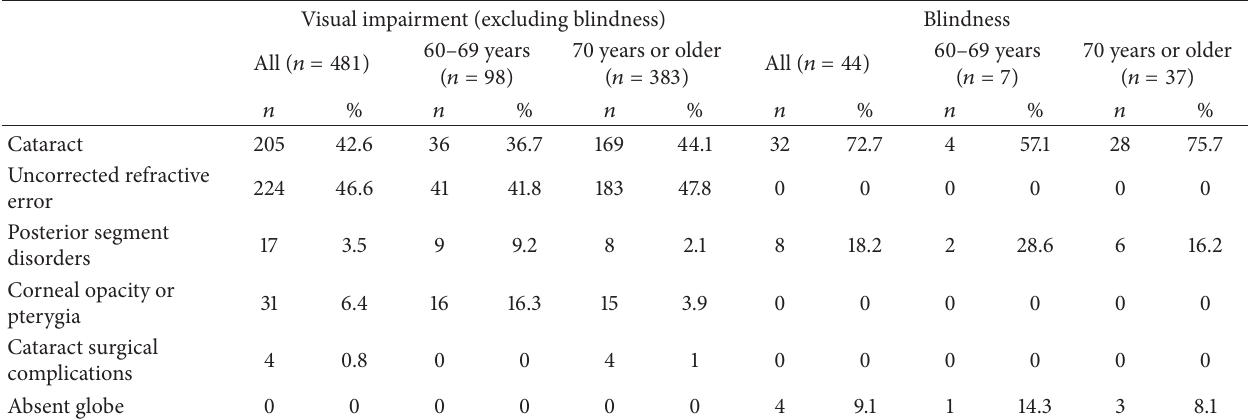
Table 2: Distribution of causes for visual impairment and